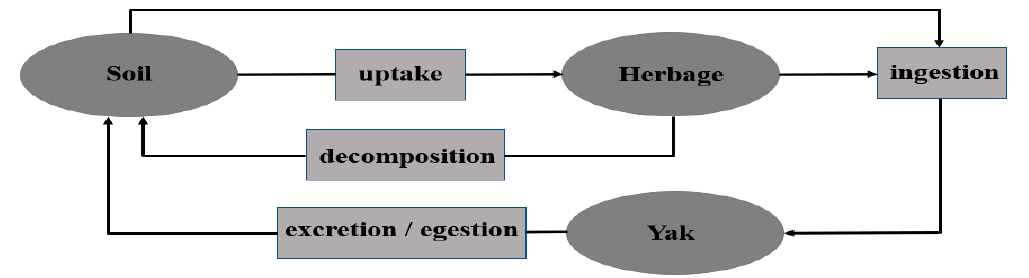
Figure 1. The cyclic path of mineral elements in a grassland grazing system.